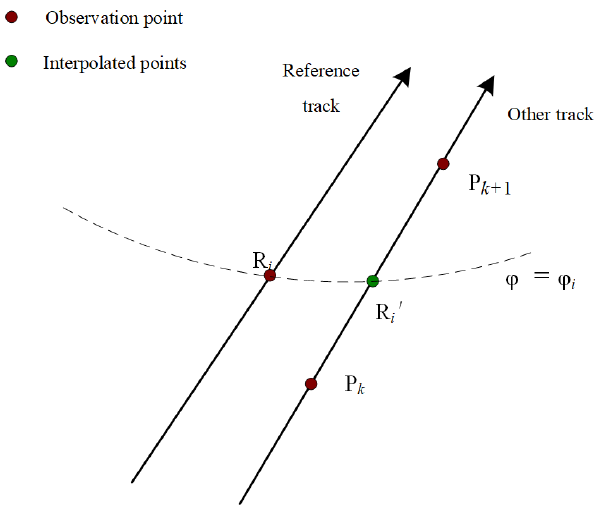
Figure 2. Simplified collinear adjustment method. R i is the obser- vation point on the reference track. P k and P k + 1 are the observation points on the other track. The latitude of R (cid:48) R i . The dashed line indicates the